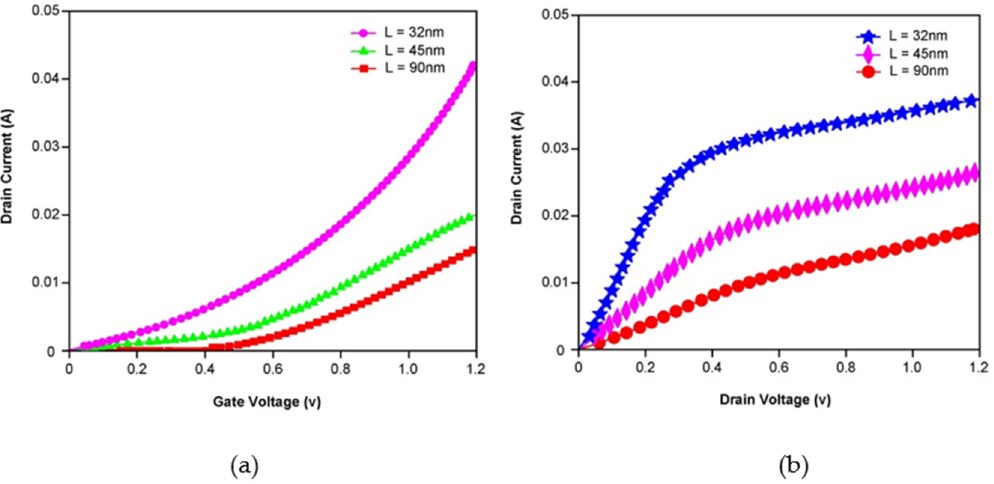
Figure 2. Drain current characteristics of Silicon substrate based FinFET with applied ( a ) Gate Voltage and ( b ) Drain Voltage for various channel lengths of L = 32 nm, 45 nm and 90 nm .